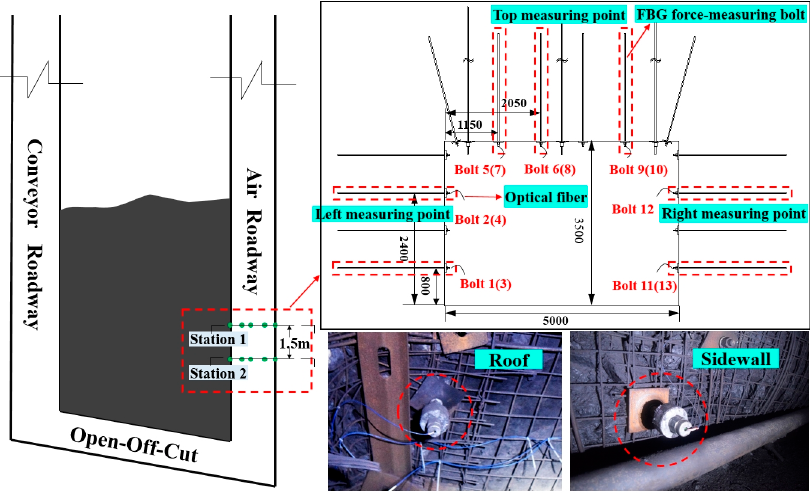
Figure 9. Installation diagram of FBG force-measuring bolt.